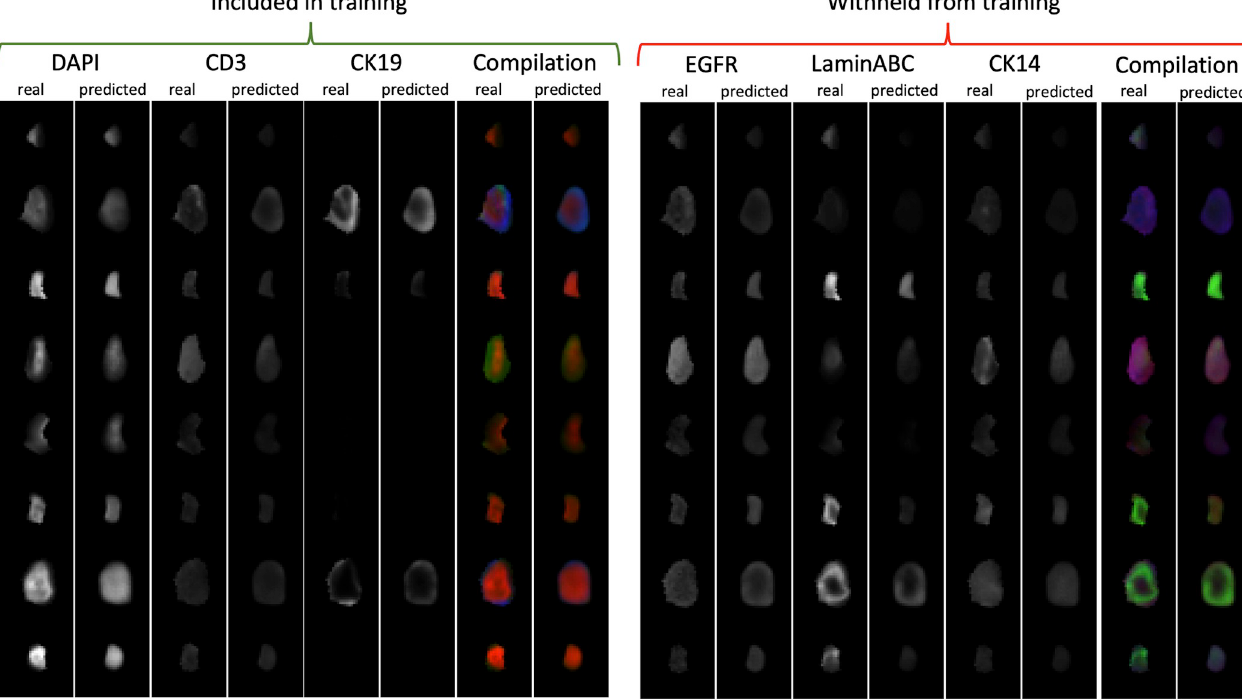
PLOS Computational Biology | https://doi.org/10.1371/journal.pcbi.1010505 September 30,